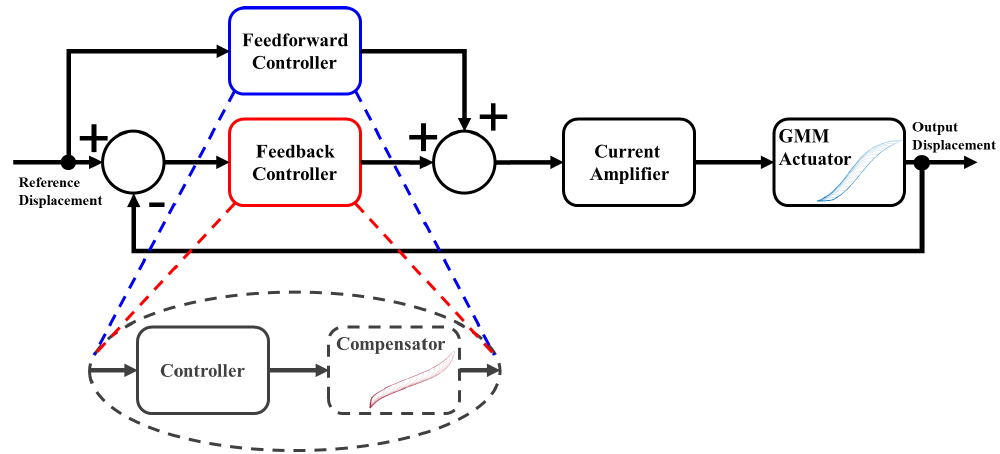
Figure 13. General control scheme for